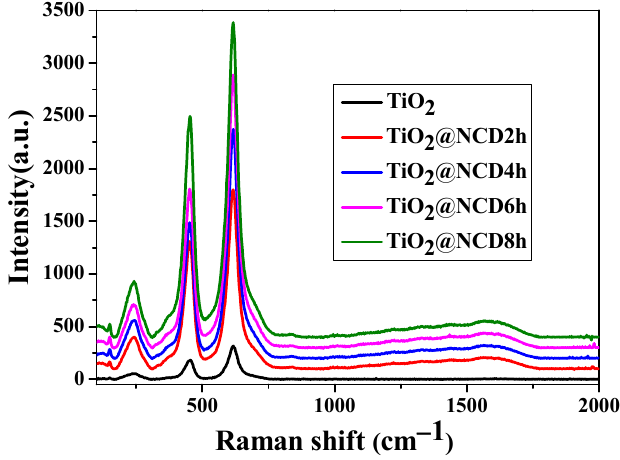
Figure 4. Raman spectra of TiO 2 and TiO 2 @NCD4h. The elemental composition and chemical binding of NCDs decorated on TiO 2 catalyst were determined by the XPS analysis (Figure 5). The survey scans illustrated the elements in two structures, e.g., C, N, Ti, and O elements in TiO 2 @NCDs4h, whereas C, Ti, and O elements were in the pristine TiO 2 [12,39] (Figure 5a). An increase in the carbon content and the presence of N1s peak compared with the bare TiO 2 evidently confirm that the NCDs were successfully decorated on TiO 2 . Ti2p spectra (Figure 5b) showed two representative peaks at 464.0 and 458.4 eV (difference: 5.6 eV), which correspond to the spin-orbit coupling for Ti2p1/2and Ti2p3/2, respectively, and was identical to those for TiO 2 [15]. Furthermore, Ti2p peaks of the TiO 2 @NCDs4h structure have considerably shifted (by 0.2 eV) compared to bare TiO 2 (Figure 5b). This is due to the electronegativity of C/Ns, which increased the binding ability of extra-nuclear electrons, hence raising the binding energy. The C 1s spectra (Figure 5c) is fitted with three peaks corresponding to C-C, C-O & C-N, and C=O & C=N bonds at 284.8, 286.0, and 288.3 eV, respectively [40]. The N1s spectra (Figure 5d) shows three peaks which appeared at 396.7 eV, 401.4 eV, and 403.7 eV, ascribed to the pyridine-N, pyrrole-N, and Graphitic-N, respectively, indicating the carbon dot doped with the N element [41,42]. In Figure S4, the peak in the O1 s region of TiO 2 @NCDs@4h was deconvoluted into three peaks at 532.3, 530.1, and 529.6 eV, which are assigned to O-H, C-O, or O-N, and Ti-O bonds in TiO 2 @NCDs4h, respectively. In agreement with the above microstructure analysis, XPS results suggest that NCDs were successfully deposited on the TiO 2